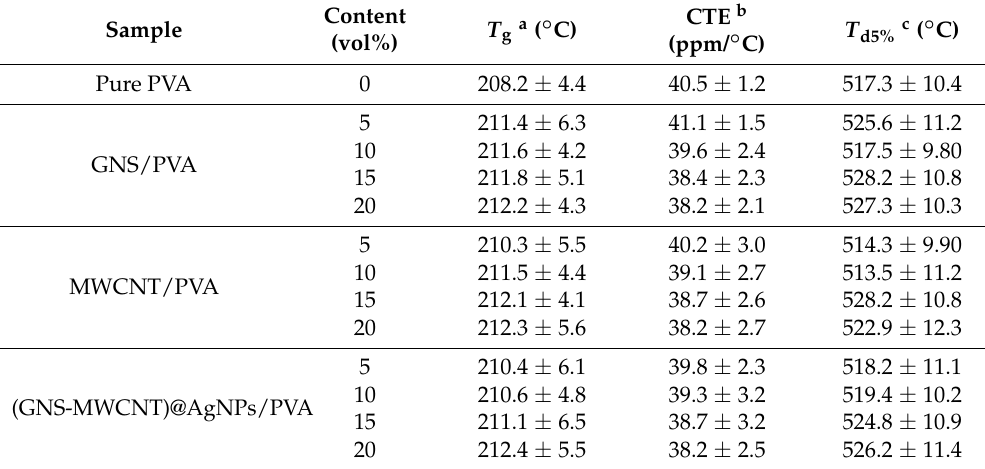
Figure 2. ( a ) SEM image of GNS@AgNPs, ( b ) TEM image of GNS@AgNPs, ( c ) Partially enlarged view of ( b ). The lattice constant d of silver was 0.23 nm. And (d) TEM image of MWCNT@AgNPs. The silver lattice diffraction pattern as shown in the inset of ( d ). SEM images of ( e ) (GNS-CNTs)@AgNPs/PVA film, ( f ) MWCNT/PVA, ( g ) GNS/PVA, ( h ) (GNS-MWCNT)/PVA, and ( i ) partially enlarged view of 20 vol% (GNS-MWCNTs)@AgNPs/PVA. Particle average size of synthesized silver was about 20 nm, thickness and surface area of 2D GNS were about 5–9 nm and 25 µ m 2 , and MWCNTs possessed 40 nm in diameter and 1–2 µ m in average length. Table 1. Glass transition temperatures, coefficient of thermal expansion, and thermal decomposition temperature of pure PVA and its composites filled with GNS, MWCNT, and (GNS-MWCNT)@AgNPs at 5%, 10%, 15%, and 20% fillers